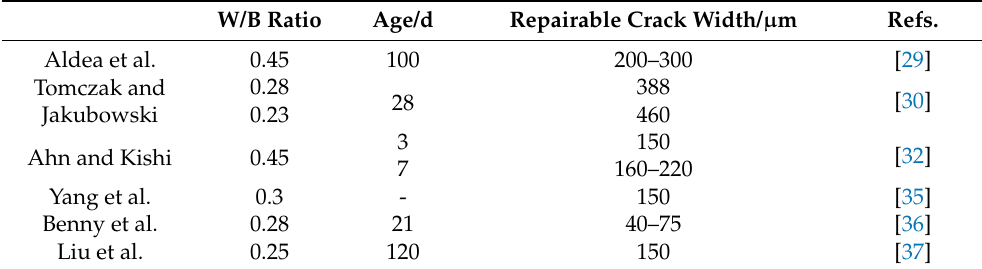
Figure 1. Rehydration repair mechanism. Table 1. Repairable crack widths by rehydration of the cement-based